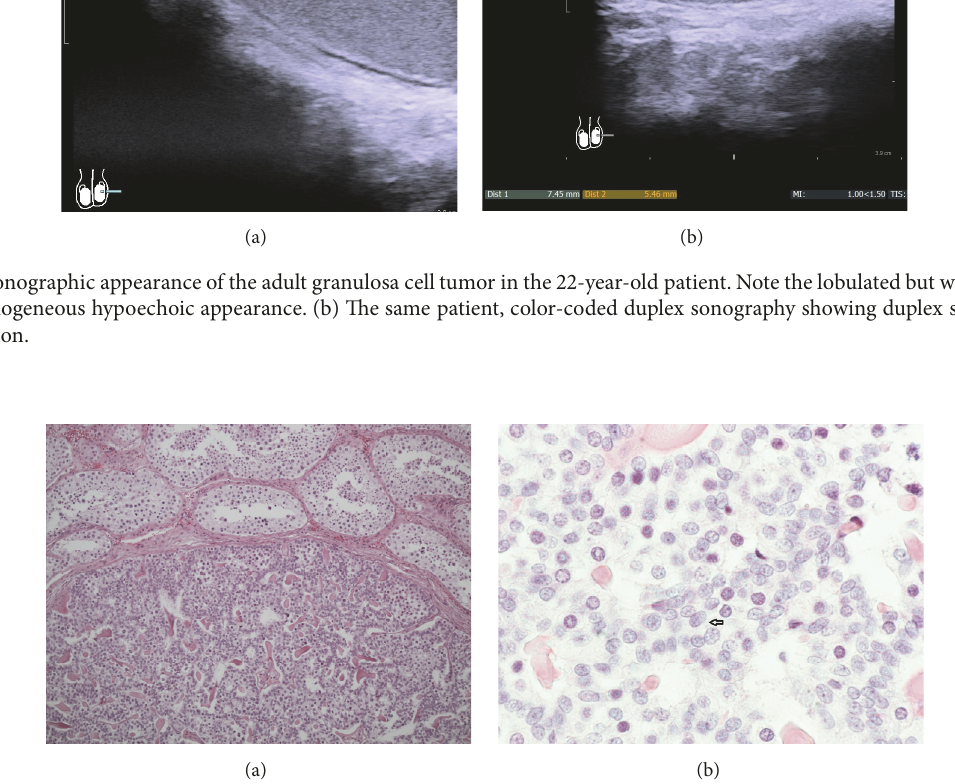
Figure 2: (a) Histological section of the neoplasm, hematoxylin-eosin stain. Well demarcated rim of the testicular neoplasm, no clear encapsulation. Normal testicular parenchyma, upper part of image. 10x magnification. (b) Histological section of the neoplasm. The tumor cells have scant cytoplasm and elongated nuclei with numerous grooves (arrow). Hematoxylin-eosin stain, magnification